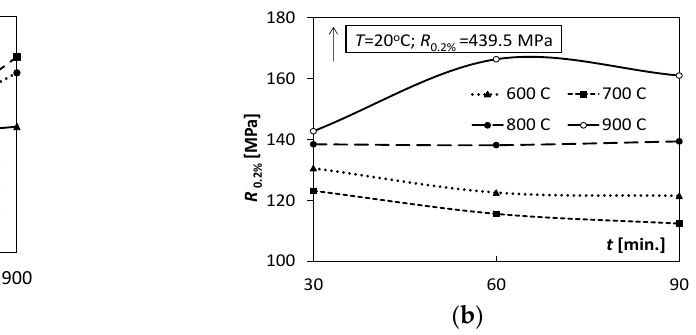
p 0.2 depending on: ( a ) temperature T , ( b ) annealing